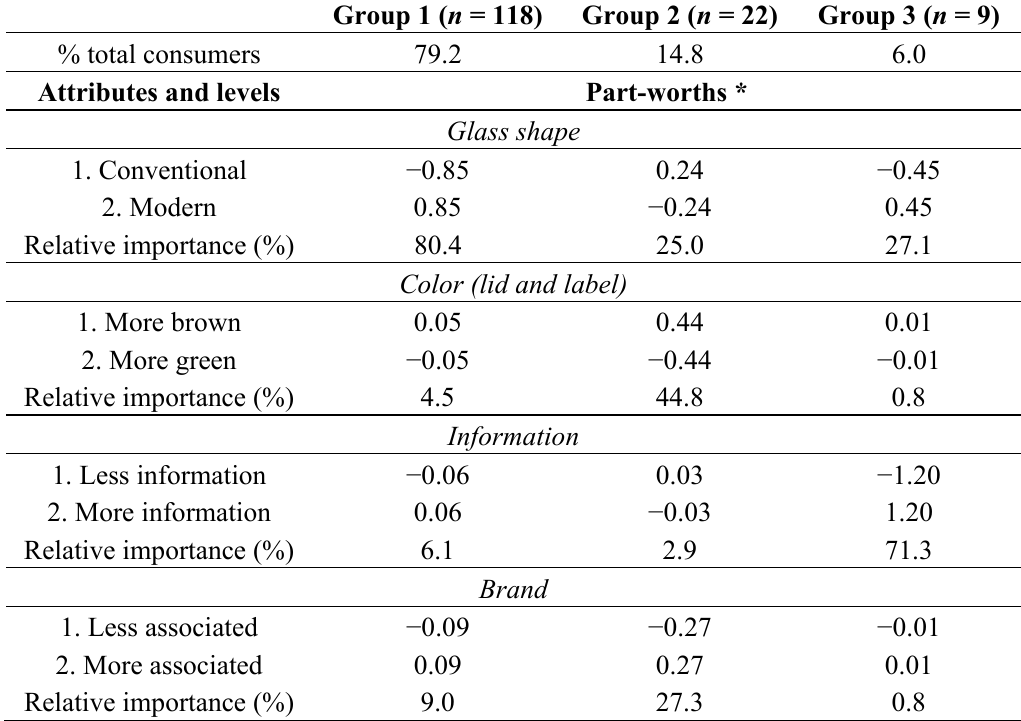
Table 3. Aggregate analysis results for each consumer